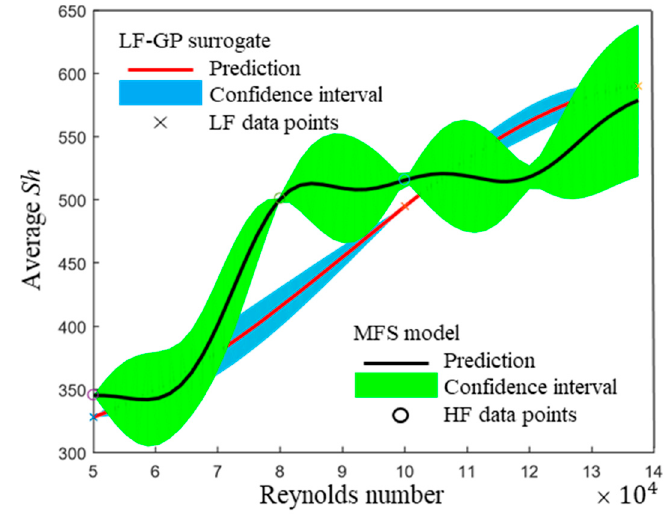
Figure 10. 1D projection of LF-GP surrogate and MFS for a fixed BL thickness of 10 mm.